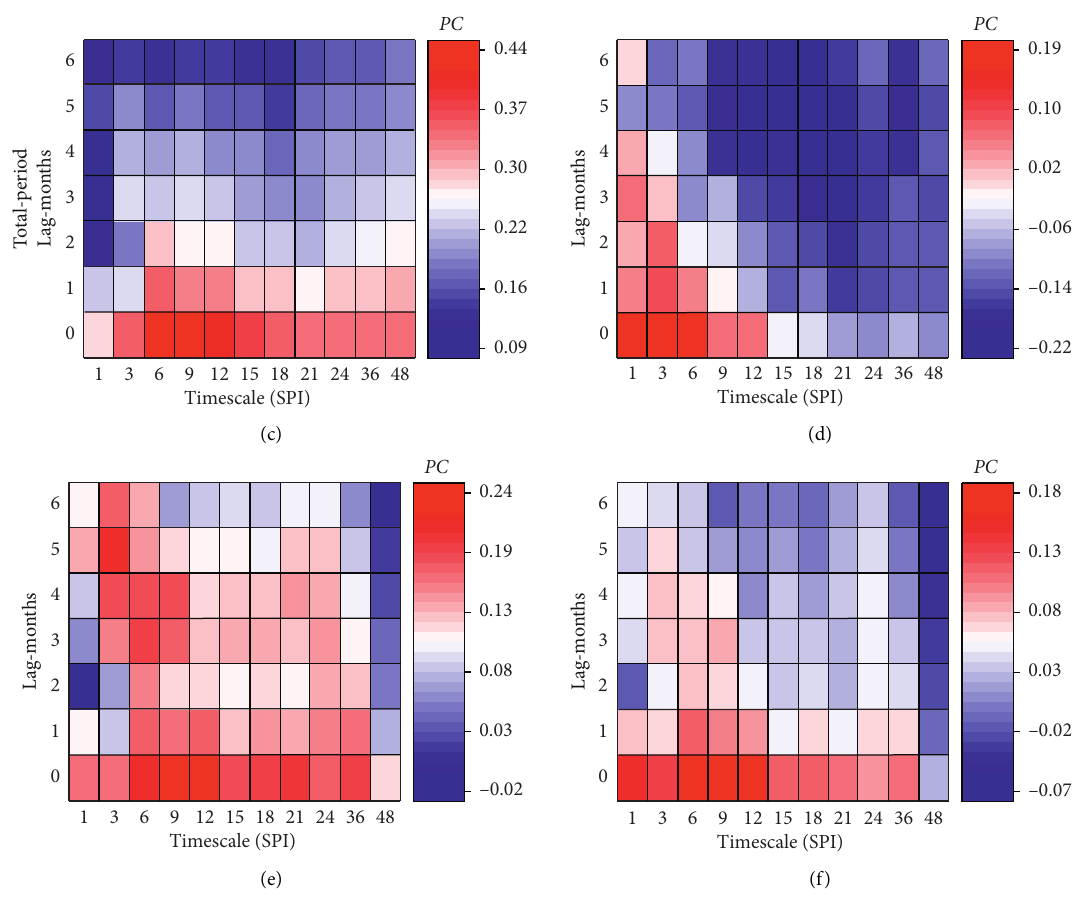
Figure 13: Heat maps showing PC between SDI-1 lagged by 0–6 months and SPI accumulation periods of 1–48 months for different timescales at different periods in the UHRB (Ylx) and MHRB (Zyx). (a) (1965–1979, PC ≥ 0.15 or ≤ ‒ 0.16, p < 0.05), (b) (1980–2012, PC ≥ 0.14, p < 0.01), and (c) (1965–2012, PC ≥ 0.11, p < 0.01) in the UHRB (Ylx) and (d) (1965–1984, PC ≥ 0.16 or ≤ ‒ 0.11, p < 0.05), (e) (1985–2012, PC ≥ 0.12, p < 0.01), and (f) (1965–2012, PC ≥ 0.10, p < 0.05) in the MHRB